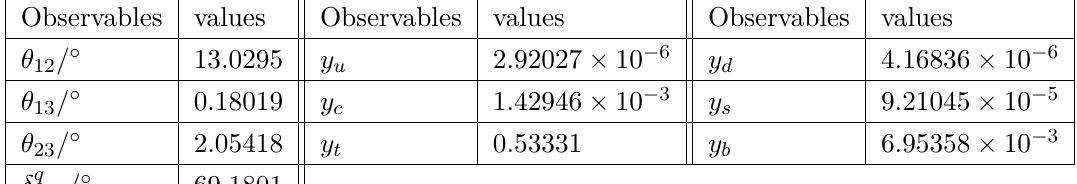
Table 7 . The predictions for the Yukawa eigenvalues, the mixing angles and the CP phase of the quark sector for tan β = 5